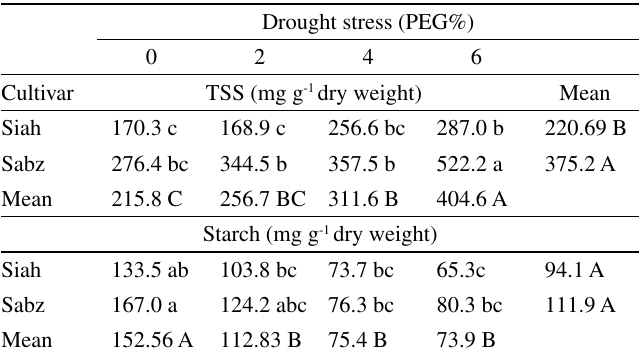
Table 5 - Interaction of water stress and cultivar on leaf TSS and starch